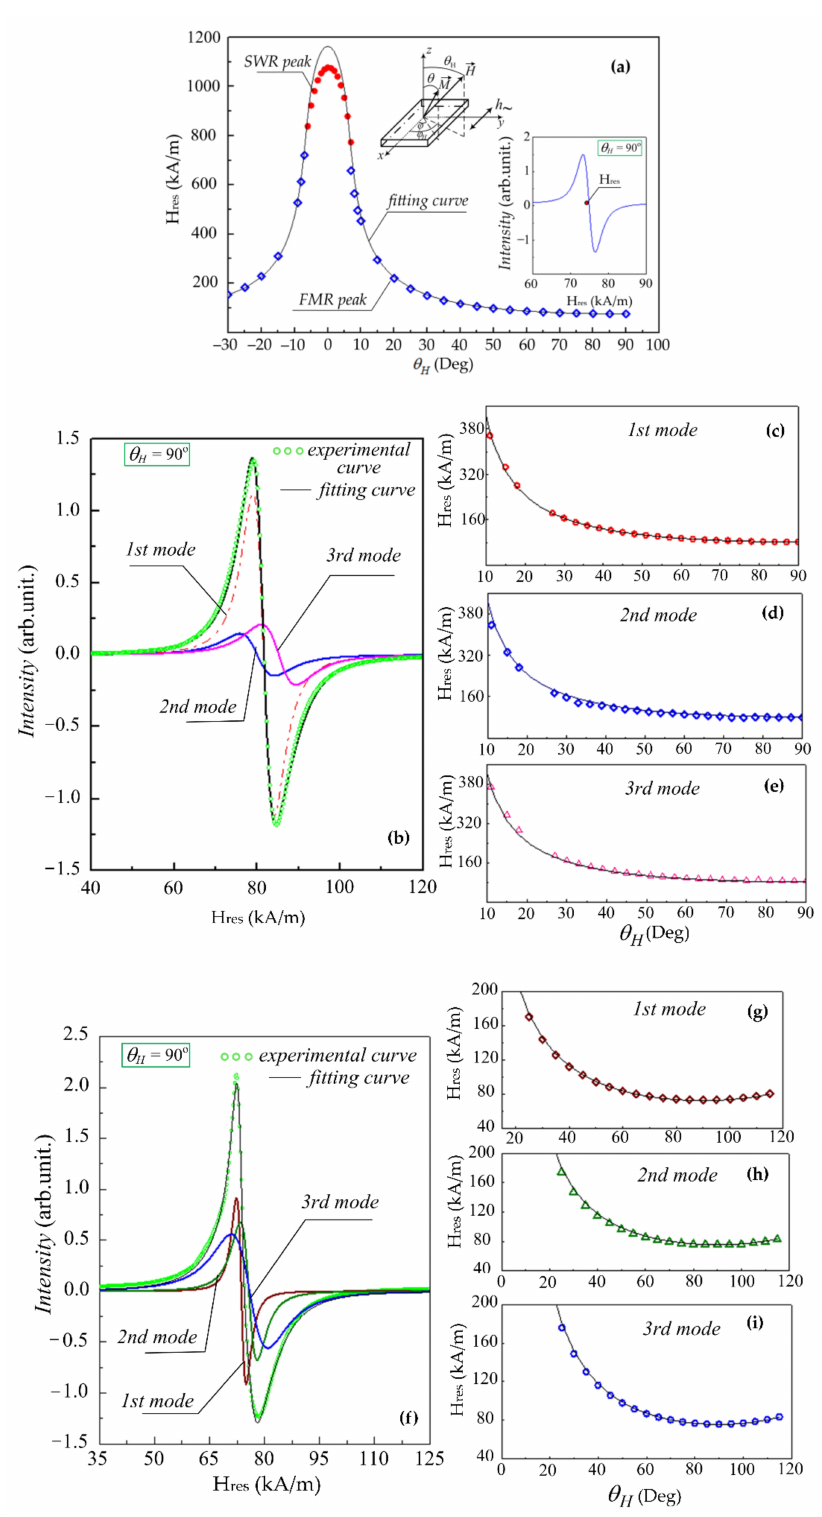
Figure 5. The examples of the microwave spectra of the one-layer films with the thickness 100 nm (inset to Figure ( a )) and 500 nm ( f ), and the multilayer film (Fe20Ni80/Cu)5 ( b ) measured at ϑ H = 90 ◦ . The solid lines demonstrate the fitting curves of the angular dependences of the resonance fields of the uniform modes fitted according to the Smit–Beljers. The resonance field of the single mode for the 100 nm film ( a ) and the resonance fields of the individual modes for the multilayer film ( c – e ) and for the 500 nm film ( g – i ) obtained from the fitting of the experimental curve are shown by different